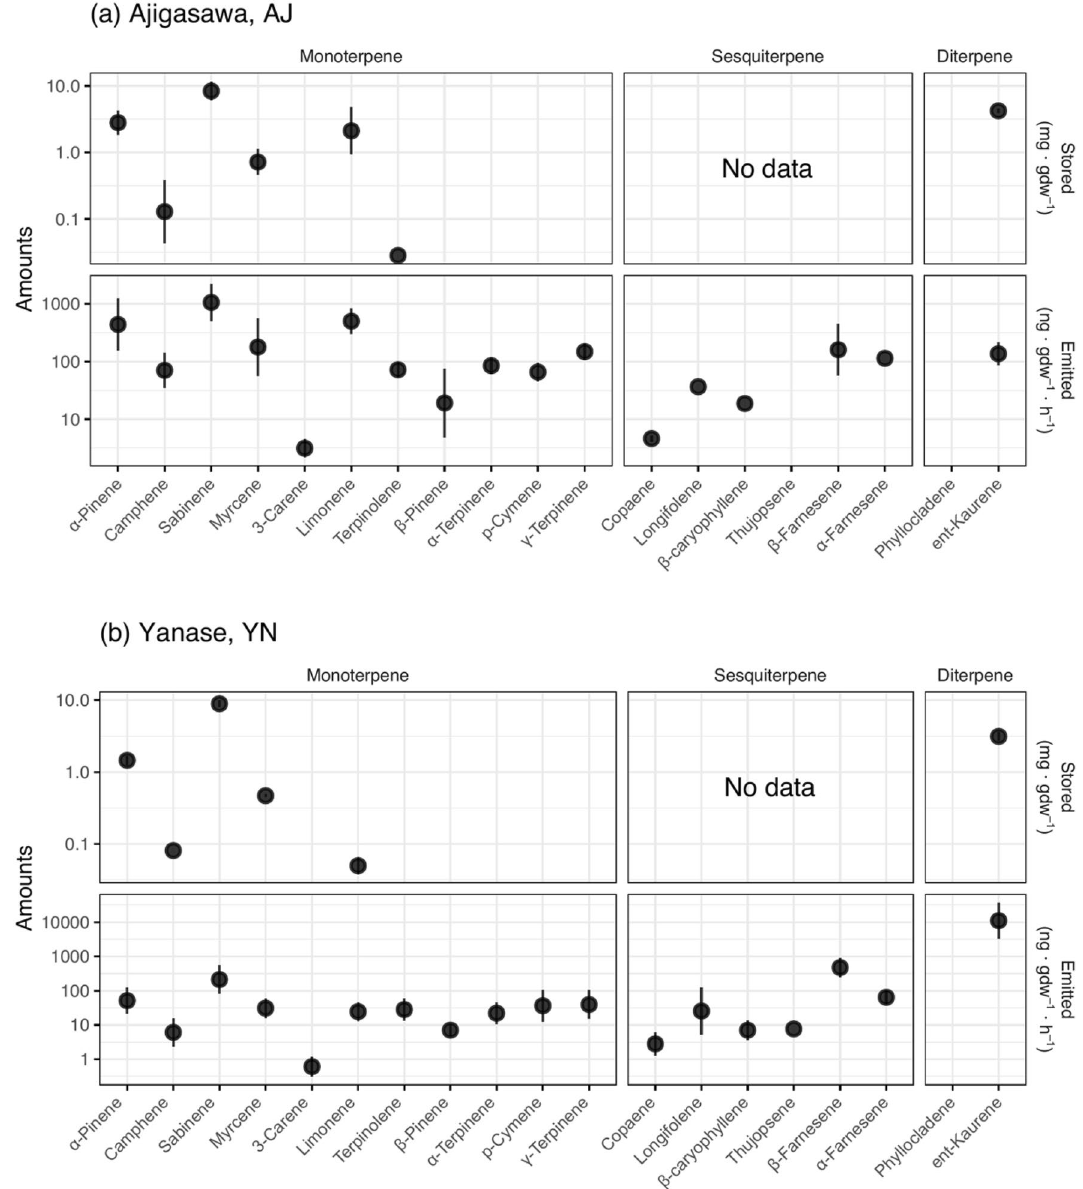
Figure 1. Stored and emitted terpenes detected in the case of Ajigasawa (above) and Yanase (below) population. Note that stored SQTs were not measured, and Sclarene was detected but not included in the analysis owing to the lack of an authentic